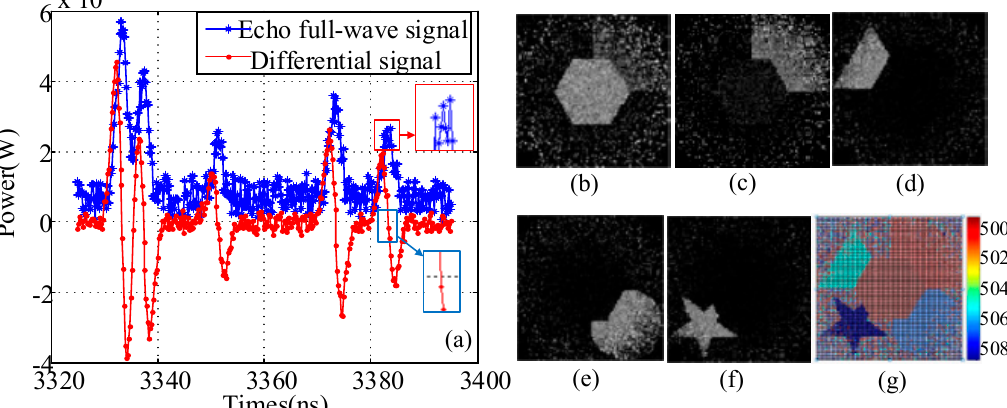
Figure 6. 3D target models: ( a ) Perspective view and ( b ) side view.